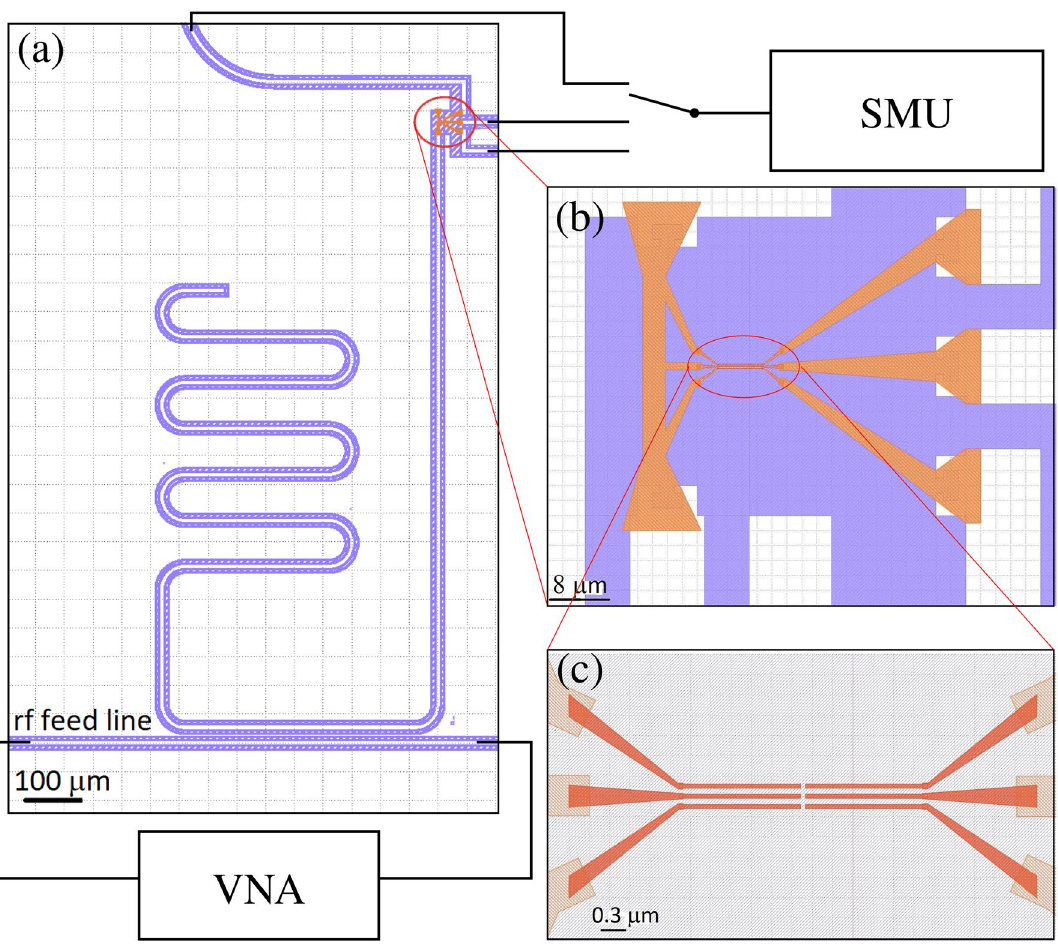
Figure 1. Sample design and experimental setup. ( a ) Design of a niobium (white color) coplanar-waveguide resonator (meandering structure), capacitively coupled to an rf feed line at the bottom, connected to a vector network analyzer (VNA). The silicon substrate is indicated in shaded blue. The red ellipse highlights a small aluminium structure (orange color), used to apply the current into the resonator and to connect the resonator to the ground plane. The external current bias is implemented by a source measure unit (SMU). The SMU ground and the potential of the on-chip niobium ground plane are connected to the microwave ground of the VNA. ( b ) Region indicated by the red ellipse in ( a ). The three fingers on the right constitute the gate electrodes. They are connected to the SMU via a switch using dc lines. ( c ) Magnified view of the current-injection structure: there is a gap of 80 nm between the gate electrodes and the opposite fingers that are galvanically connected to the